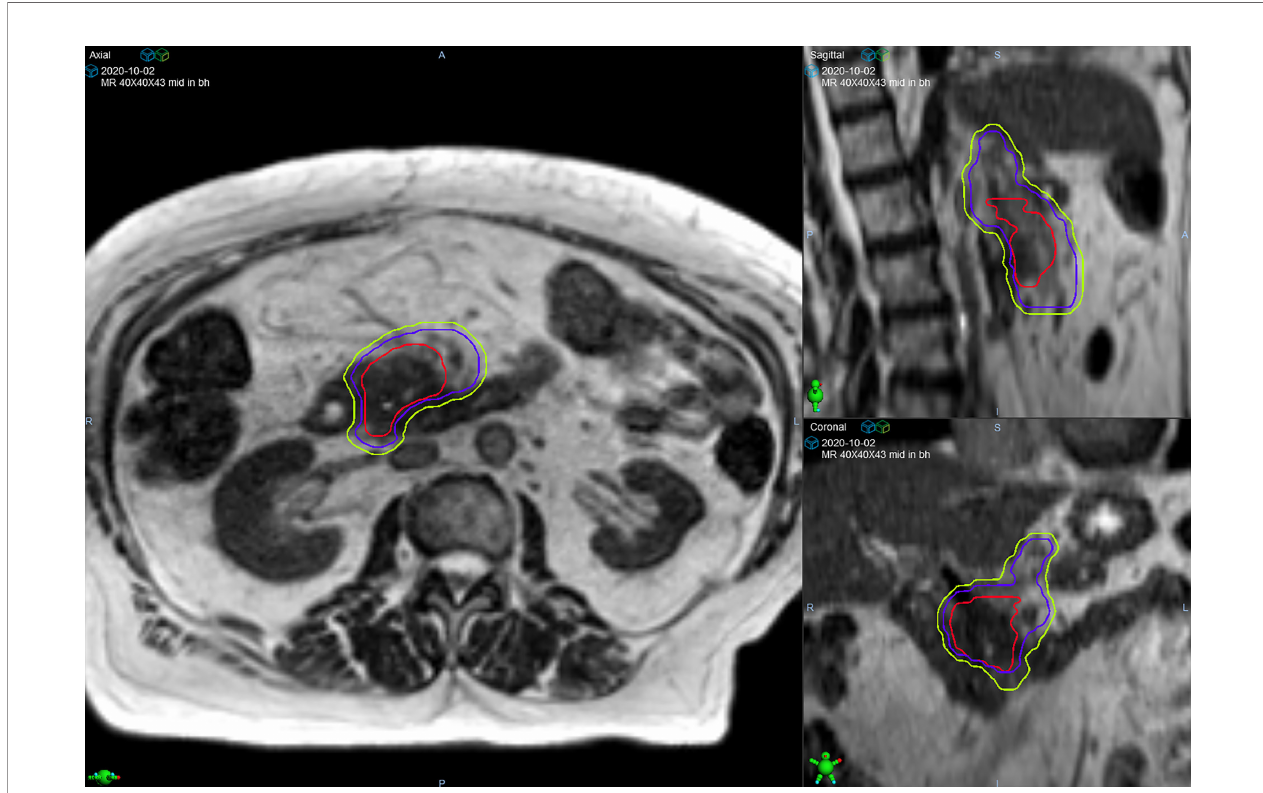
FIGURE 1 | Target volumes of a patient with pancreatic head/uncinate process lesion who was prescribed 50 Gy in 5 fractions. The gross tumor volume (red line) is surrounded by the clinical target volume (purple line) that includes the celiac axis and superior mesenteric artery. The planning target volume (green line) was created from a 3 mm expansion of the clinical target